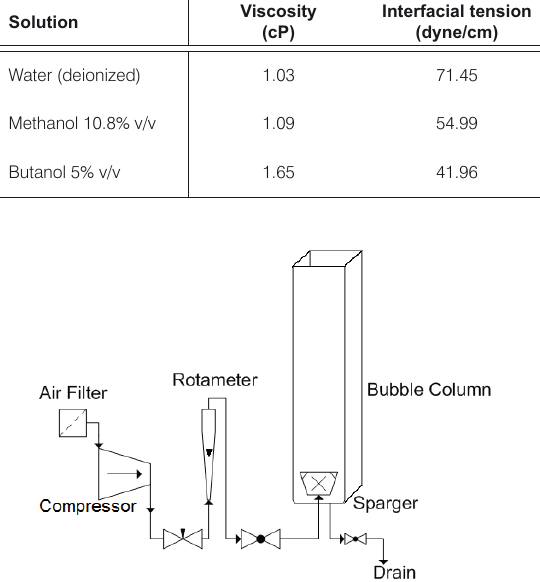
0.40.450.50.550.6 Figure 4. Coalescence efficiency vs. surface tension, plotted for a bubble of 0.5 mm in diameter in touch with a bubble of 5 mm in